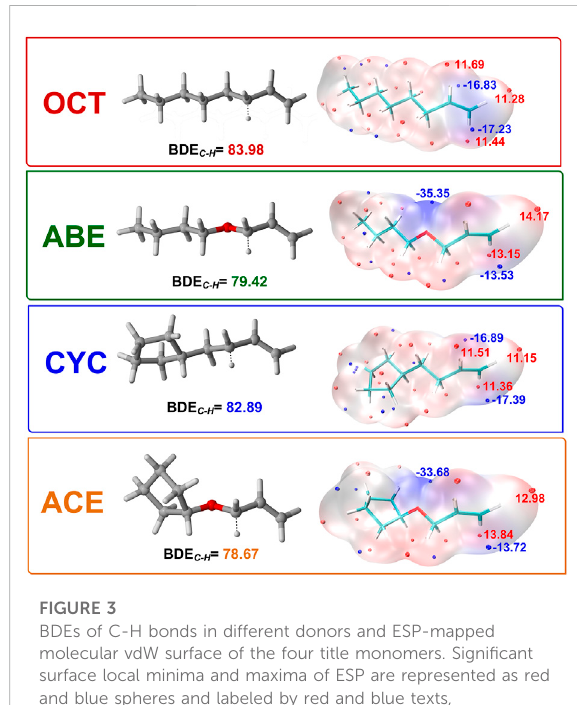
FIGURE 3 BDEs of C-H bonds in different donors and ESP-mapped molecular vdW surface of the four title monomers. Signi fi cant surface local minima and maxima of ESP are represented as red and blue spheres and labeled by red and blue texts, respectively (Unit: